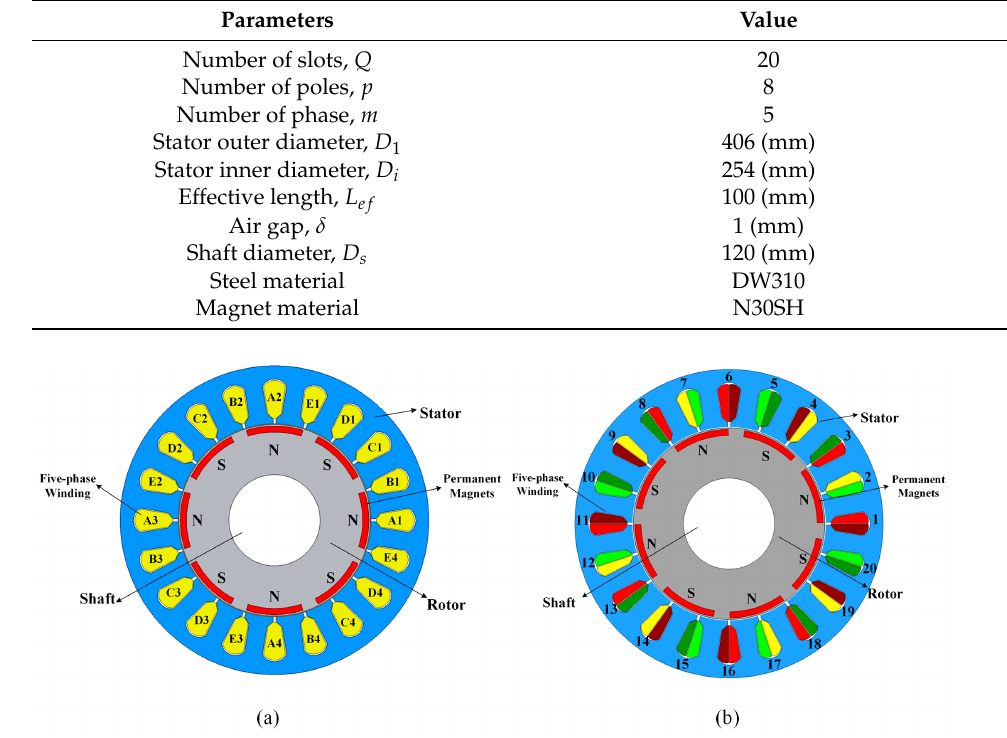
Table 2. Main geometry dimensions of five-phase single-turn motor and distributed PMSM.